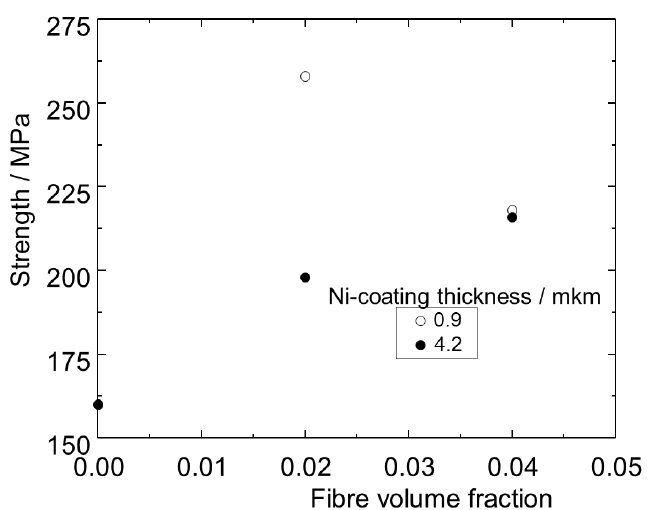
Figure 8. Bending strength of carbon-fibre/aluminium-matrix composites with two values of Ni-coating thickness. After experimental data published in [29 Error! Bookmark not defined. ].